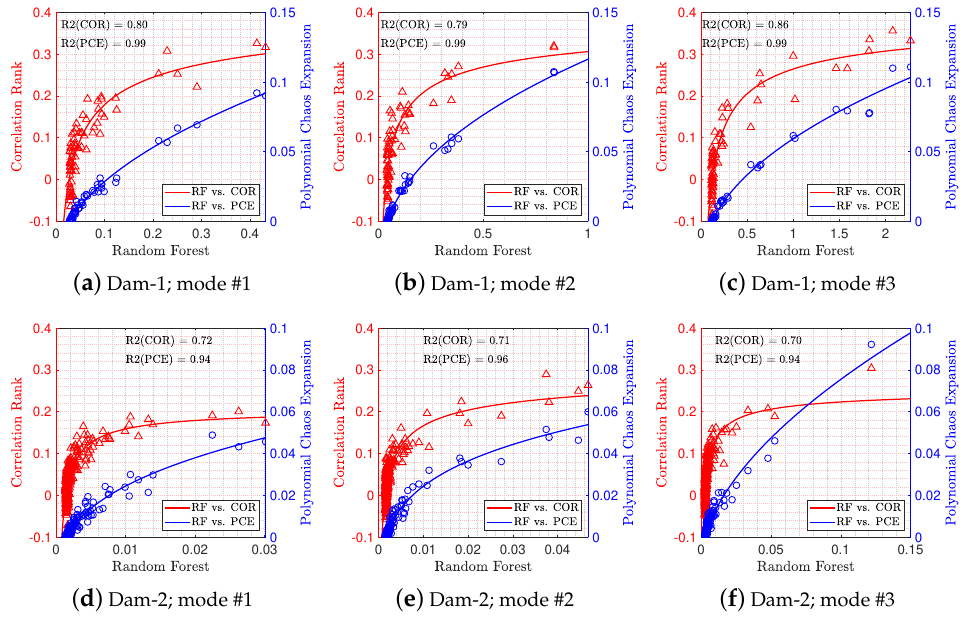
Figure 17. Correlation among three sensitivity metrics for various vibration